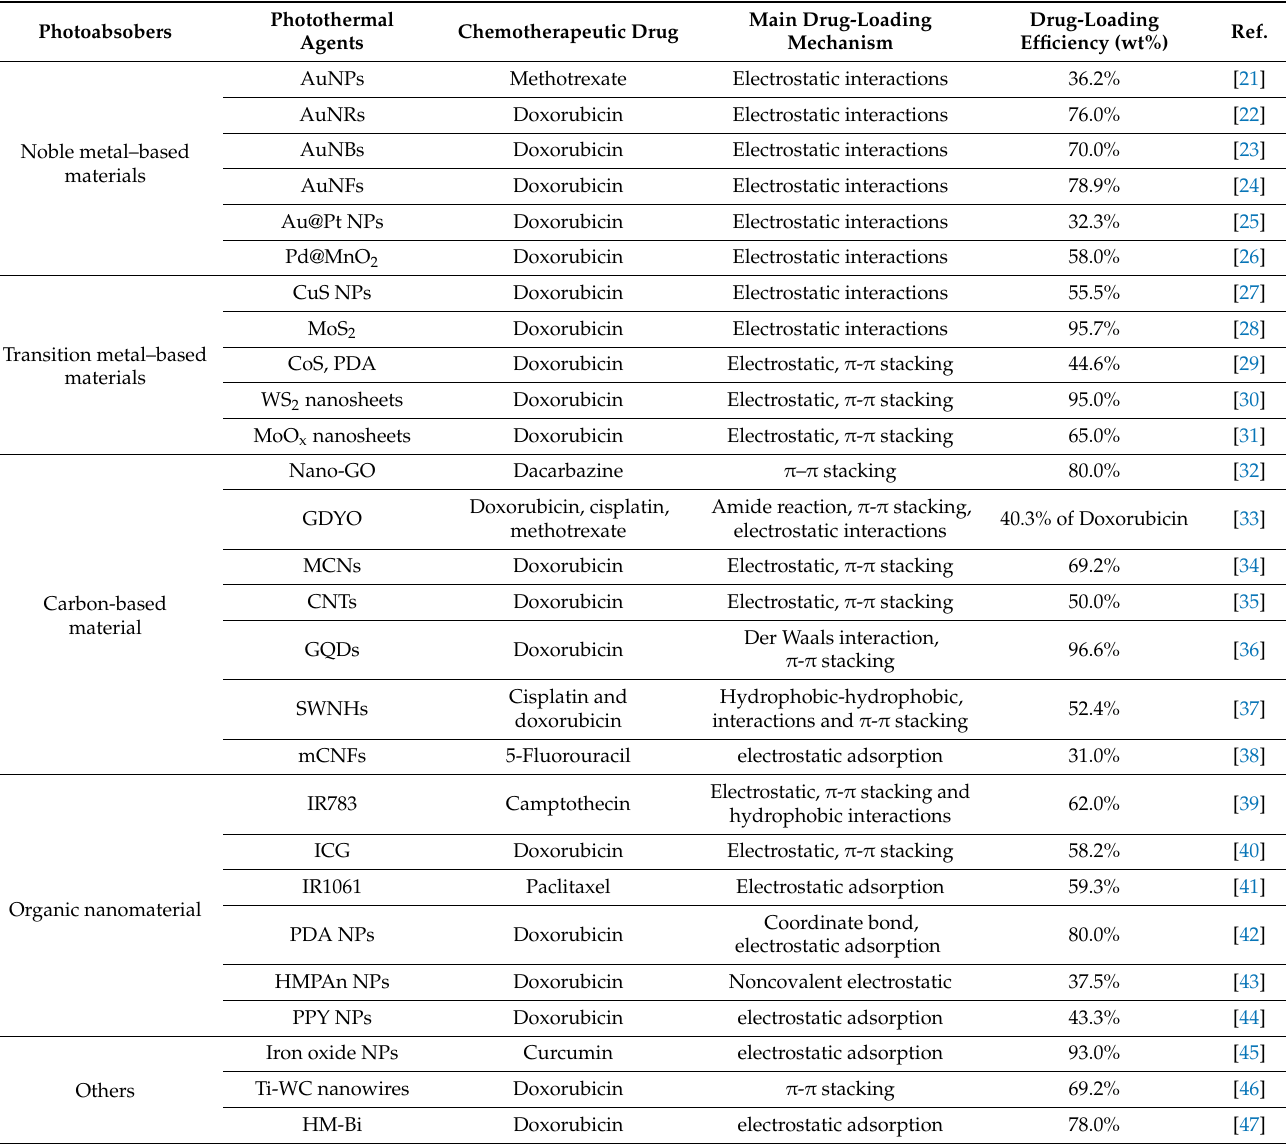
Table 1. A summary of photothermal agents as carriers for high drug-loading